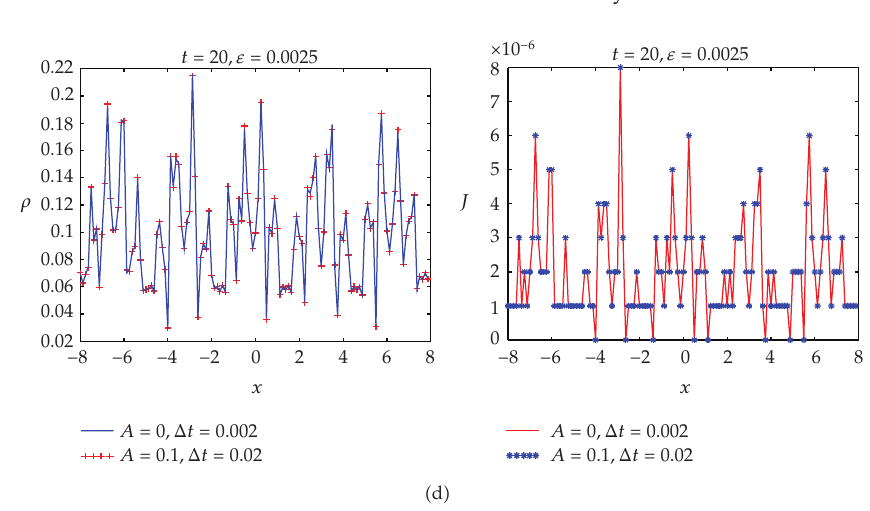
Figure 1: Numerical solutions for the strong O (cid:3) 1 (cid:4) defocusing nonlinearity by using ED2/EP2. λ (cid:6) 1, ε (cid:6) 0 . 0025, N (cid:6) 256. “ − “: (cid:3) A, Δ t (cid:4) (cid:6) (cid:3) 0 , 0 . 001 (cid:4) , (cid:3) 0 , 0 . 002 (cid:4) , “ (cid:5) (cid:5) (cid:5) ”, “ ∗ ∗ ∗ ”: (cid:3) A, Δ t (cid:4) (cid:6) (cid:3) 0 . 1 , 0 . 01 (cid:4) , (cid:3) 0 . 1 , 0 . 02 (cid:4) . (cid:3) a (cid:4) t (cid:6) 0 . 5, (cid:3) b (cid:4) t (cid:6) 1 . 5, (cid:3) c (cid:4) t (cid:6) 10, (cid:3) d (cid:4) t (cid:6)